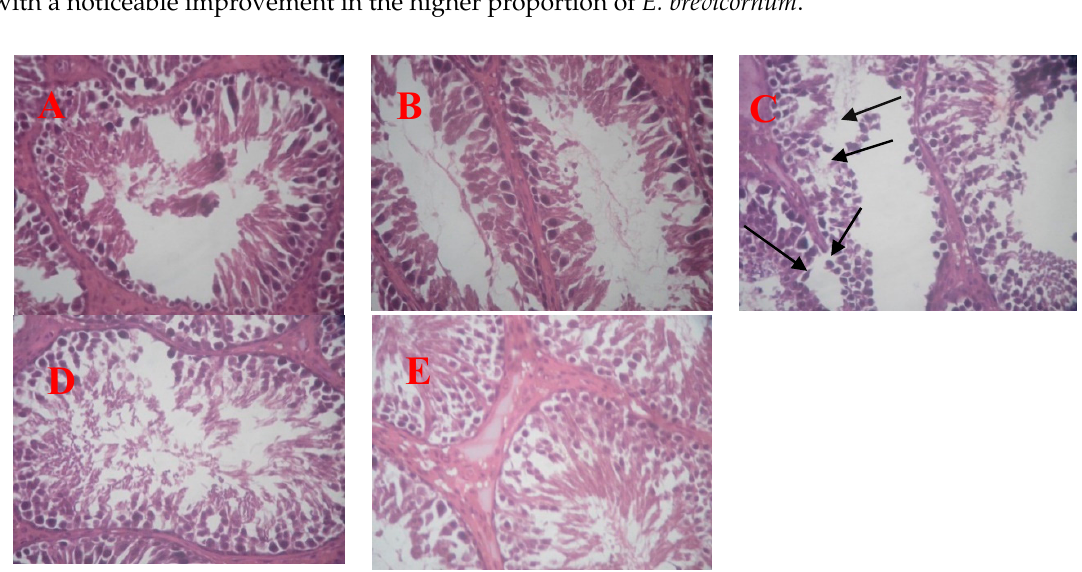
Figure 7. Plate ( A ): photomicrograph of the rat testis in the control rats shows normal, intact seminiferous tubules with normal lining epithelium and stratified seminiferous epithelium with normal interstitial connective tissue. Plate ( B ): photomicrograph of the rat testis in Group 2, which received E. brevicornum extract at a dose of 2.43 g/kg/day, show normal testicular parenchyma. Plate ( C ): photomicrographs of the testis in Group 3, which received tramadol at doses of 50 mg/kg/day and oral daily plate C, show necrosis, degeneration of the seminiferous tubule, sloughing of the stratified seminiferous epithelium, spermatogenic cells, and Sertoli cells, indicated with black arrows. Plate ( D ): photomicrographs of the rat testis of Group 4, which received tramadol at 50 mg/kg/day for 65 days, followed by TAM and E. brevicornum extract at a dose of 0.81 g/kg/day for another 65 days, show slight destruction and sloughing of spermatogenic cells, with slight hyperplasia of Leydig cells and slightly hyaline degeneration of the interstitial CT. Plate ( E ): photomicrographs of the testis in Group 5, which received tramadol at 50 mg/kg/day for 65 days, followed by tramadol and E. brevicornum extract at a dose of 2.43 g/kg/day for another 65 days.